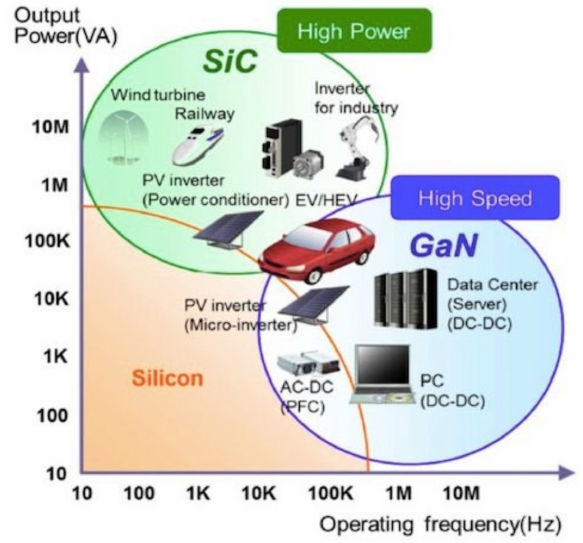
Figure 4. Applications based on WBG materials. Image used courtesy of Georgia